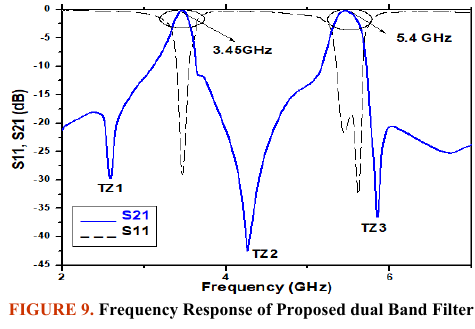
FIGURE 9. Frequency Response of Proposed dual Band Filter